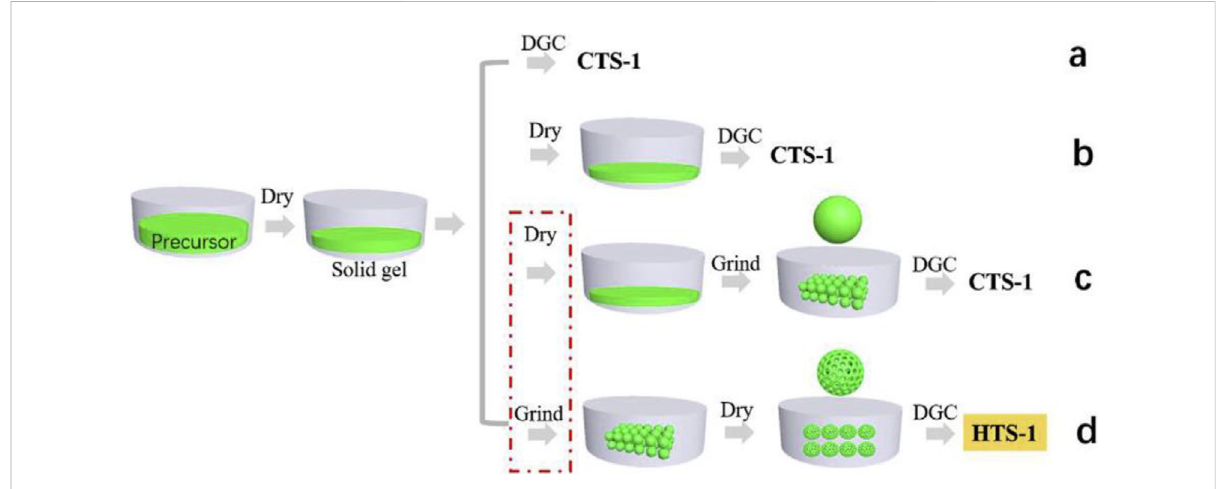
FIGURE 4 MechanismoftheformationofHTS-1zeolite.ThedrygelwithcompactstructurewasconvertedtoconventionalTS-1 (a – c) andloosecompact structure was converted to hierarchical TS-1 (d) . Reprinted with permission from Du et al. (2019). Copyright 2018 Elsevier.